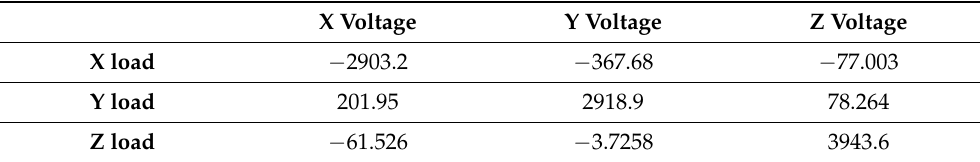
Table 7. 3-by-3 sensitivity matrix of test sensor. For any given value, its column represents the axial component of the voltage reading being mapped from, and its row represents the axial component of the estimated weight being mapped to. For example, − 180.02 in row 1, column 2 is the scaling factor applied to the Y-component of the voltage reading to get a least-squares regression estimate of the X-component of the load.